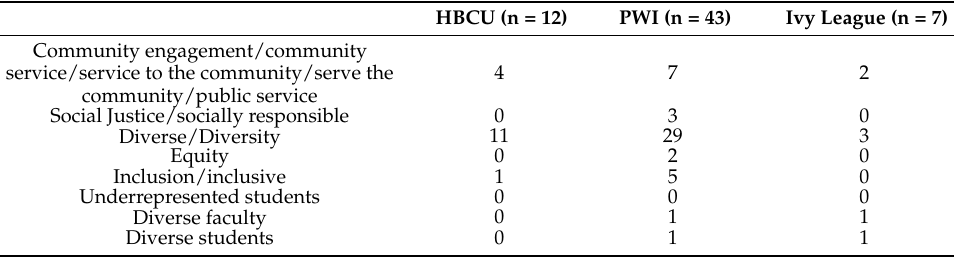
Table 3. Frequency of relevant terms in mission